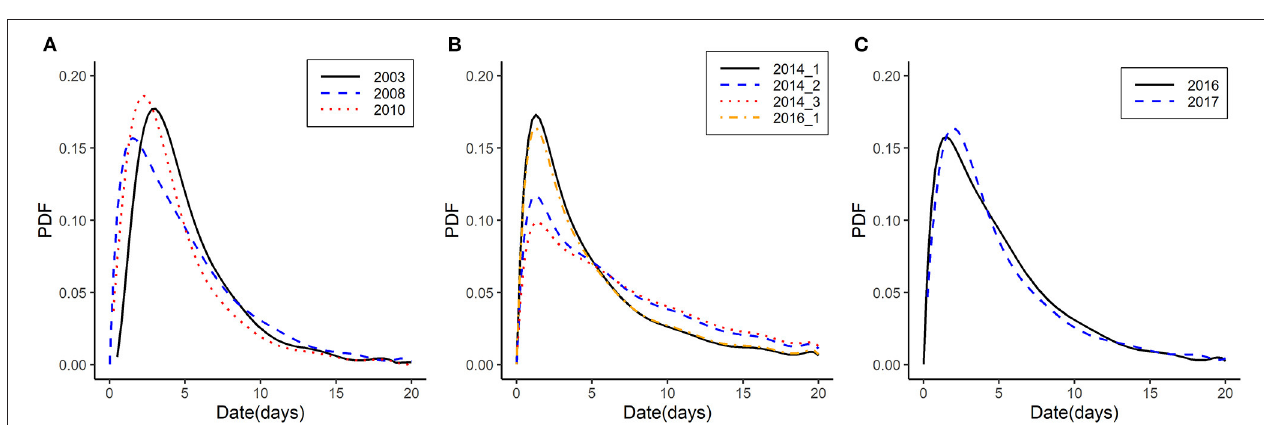
FIGURE 2 | A schematic representation of HPAI transmission between farms.